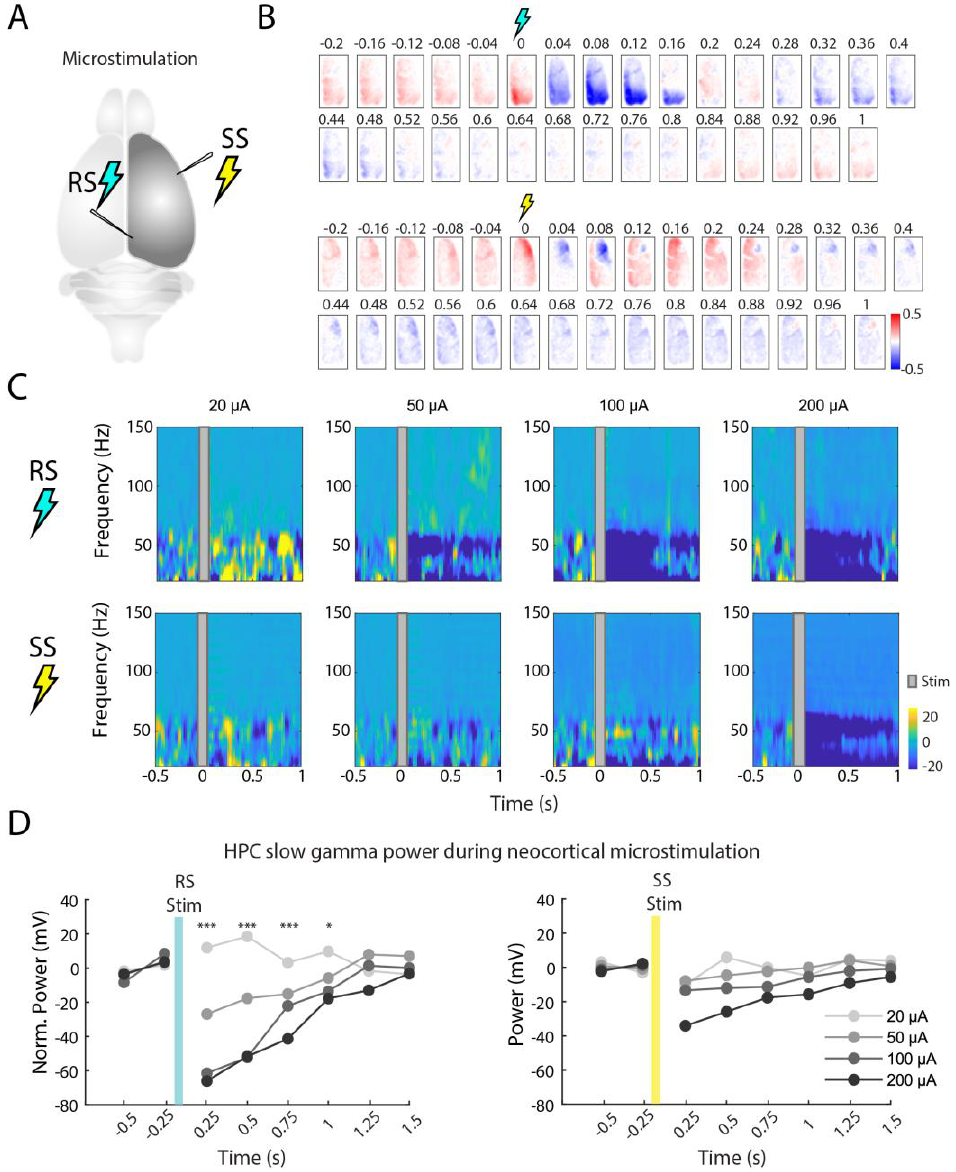
Figure 5. The influence of cortical microstimulation on cortical and hippocampal activities. ( A ) Schematic of the microstimulation zone in the retrosplenial (RS) and somatosensory (SS) cortices. ( B ) Cortical voltage activity patterns following RS and SS stimulations (10 ms stimulation; 200 µA; average of 50 stimulation events). Note that after the short period of increased activity, a continuous suppression takes place during the subsequent second. ( C ) Hippocampal CA1 spectrogram at 20, 50, 100 and 200 µA for the RS and SS stimulation. ( D ) Baseline normalized power of gamma (20 – 50 Hz) around the 20, 50, 100 and 200 µA stimulations (* p < 0.05, and *** p < 0.0005, repeated-measures ANOVA, N = 50 stimuli for each condition).